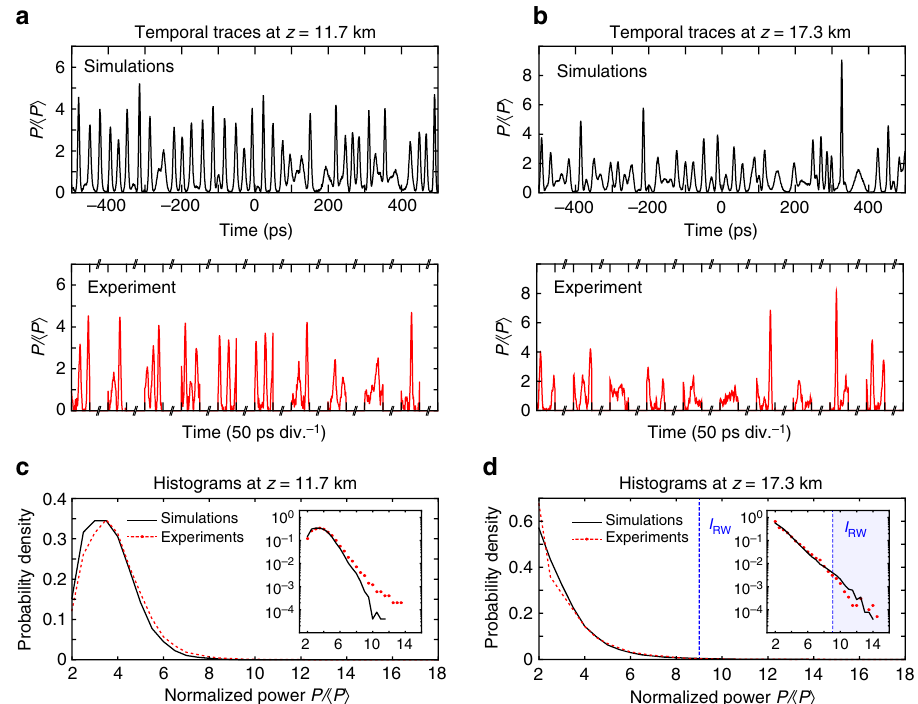
Figure 3 | Time lens results and histograms. Experimental results at ( a ) 11.7km and ( b ) 17.3km showing intensity profiles from simulations (top, black) and experiments (bottom, red) as indicated. Plotted intensities P are normalized with respect to the average output background power h P i and plotted against time after rescaling to account for the effect of magnification. The experimental results are shown for sequential measurement windows (note the broken axis between measurements). ( c , d ) Histograms of the peak intensities (shown as normalized probability density) from the chaotic pulse trains at 11.7 and 17.3km respectively, comparing experiment (red) and simulation (black). The insets plots the histograms on semi-logarithmic axes. The calculated rogue wave intensity threshold ( I RW ) is shown as a dashed blue